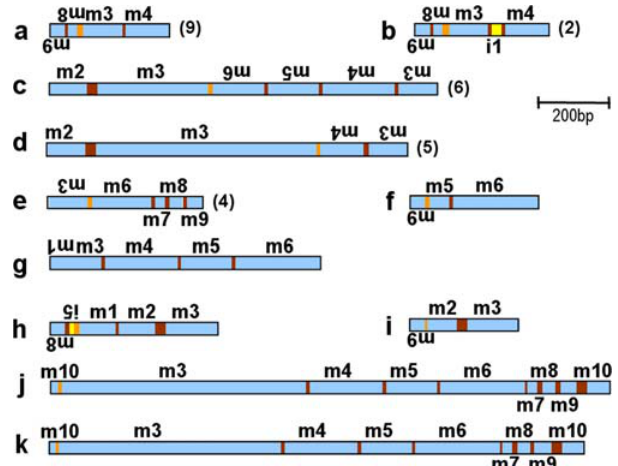
Figure 5. Schematic representation of aberrantly rearranged (mis-unscrambled) S.lemnaeactinI sequences that do not fit into a productive rearrangement pathway. MDS regions in blue, IESs in yellow and authentic pointers in maroon. Cryptic pointers in aberrant molecules are orange. (The cryptic pointers are provided in the same order in Table S2B, and the sequences of full-length aberrantly rearranged molecules are provided in Figure S5 as well as in Data S1 file ‘‘SlActinIPermuted.fas’’.) Note that with the exception of case b (recovered twice) and h, all rearranged examples lack IES sequences entirely. In addition, all cryptic pointer repeats in these molecules, with the exception of the left pointer in case h, are present in the macronuclear sequence. Nearly half of the aberrant molecules shown involve illegitimate recombination with a cryptic pointer at the left end of MDS 3 (Figure 3, bottom). This may be partly observer bias, though, because MDS 3 is very long and was surveyed in most experiments. Redundancy of sequences a–e is shown in